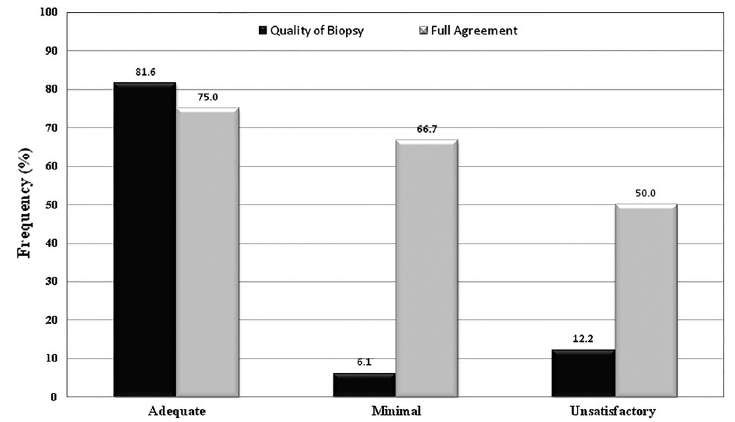
Figure 2. Percentage of full agreement in biopsy specimens strati fi ed by specimen adequacy (quality of